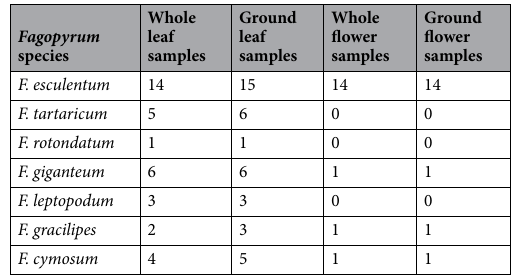
Table 3. Number of whole and ground samples of different buckwheat ( Fagopyrum ) species used in the